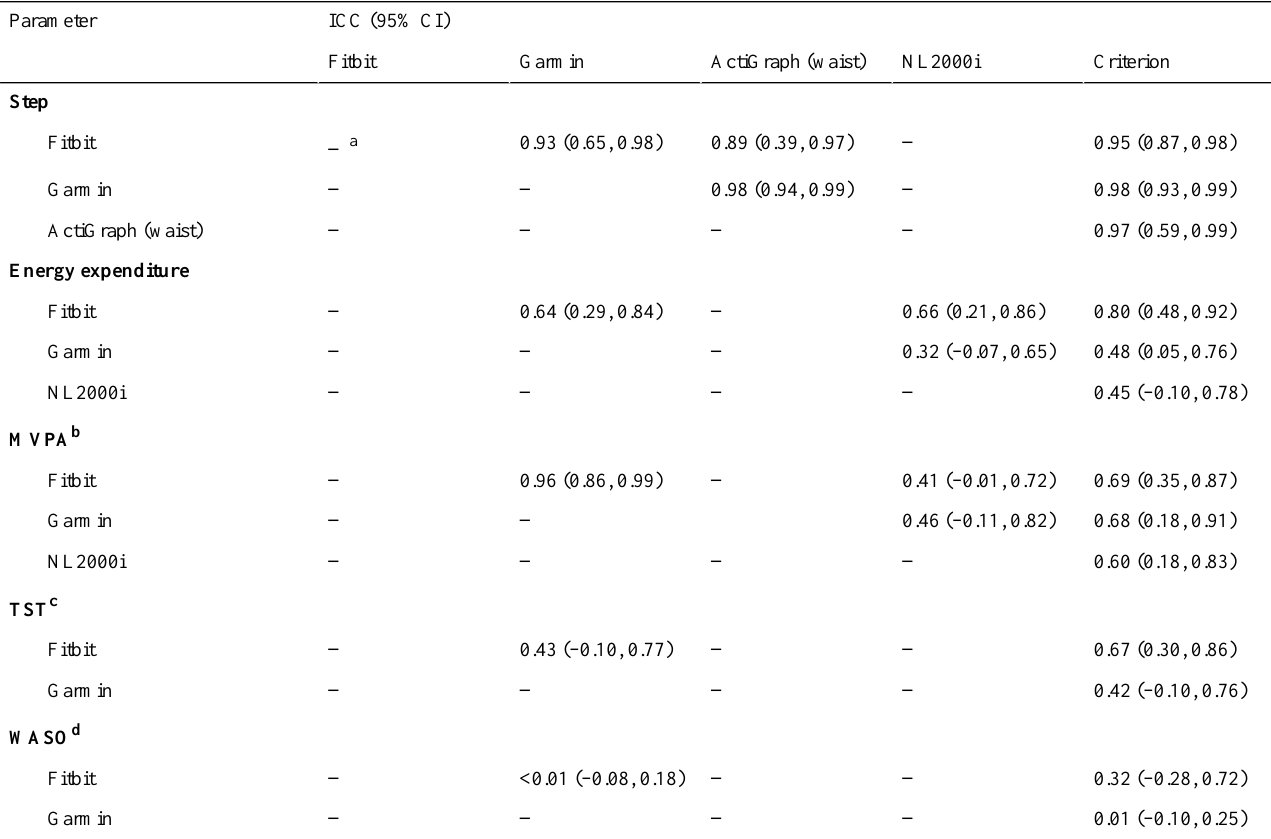
Table 3. Intraclass correlation (ICC) and 95% CI for each parameter and tracker